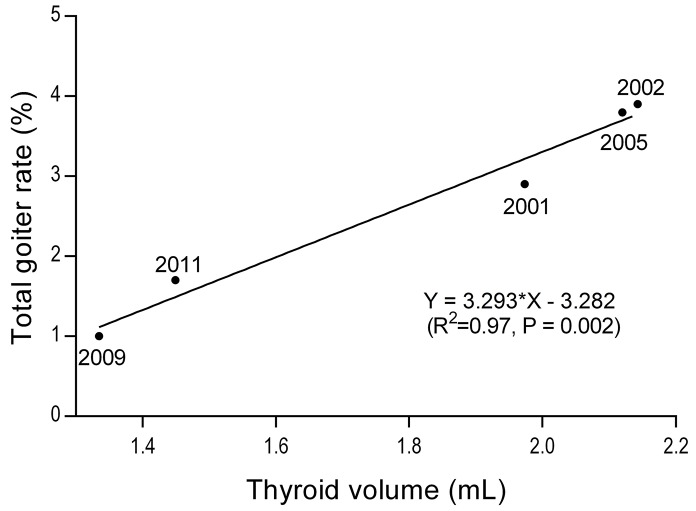
Correlation between average thyroid volume (Tvol) and thyroid goiter rate (TGR) after elimination of IDD.The numbers around points indicate the survey years. The data of TGRs and geometric means of Tvol from 2001 to 2011 were analyzed.